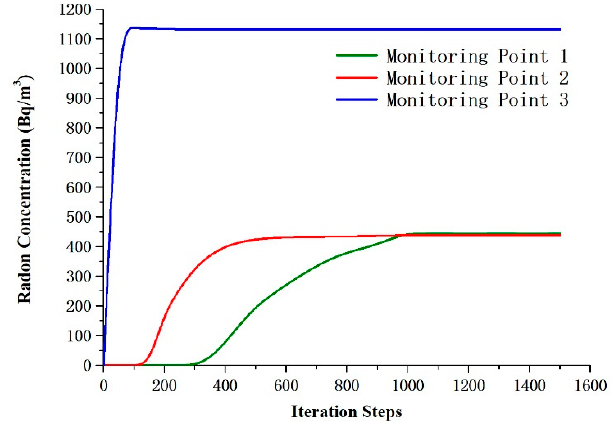
Figure 5. Radon concentration change at the monitoring points.